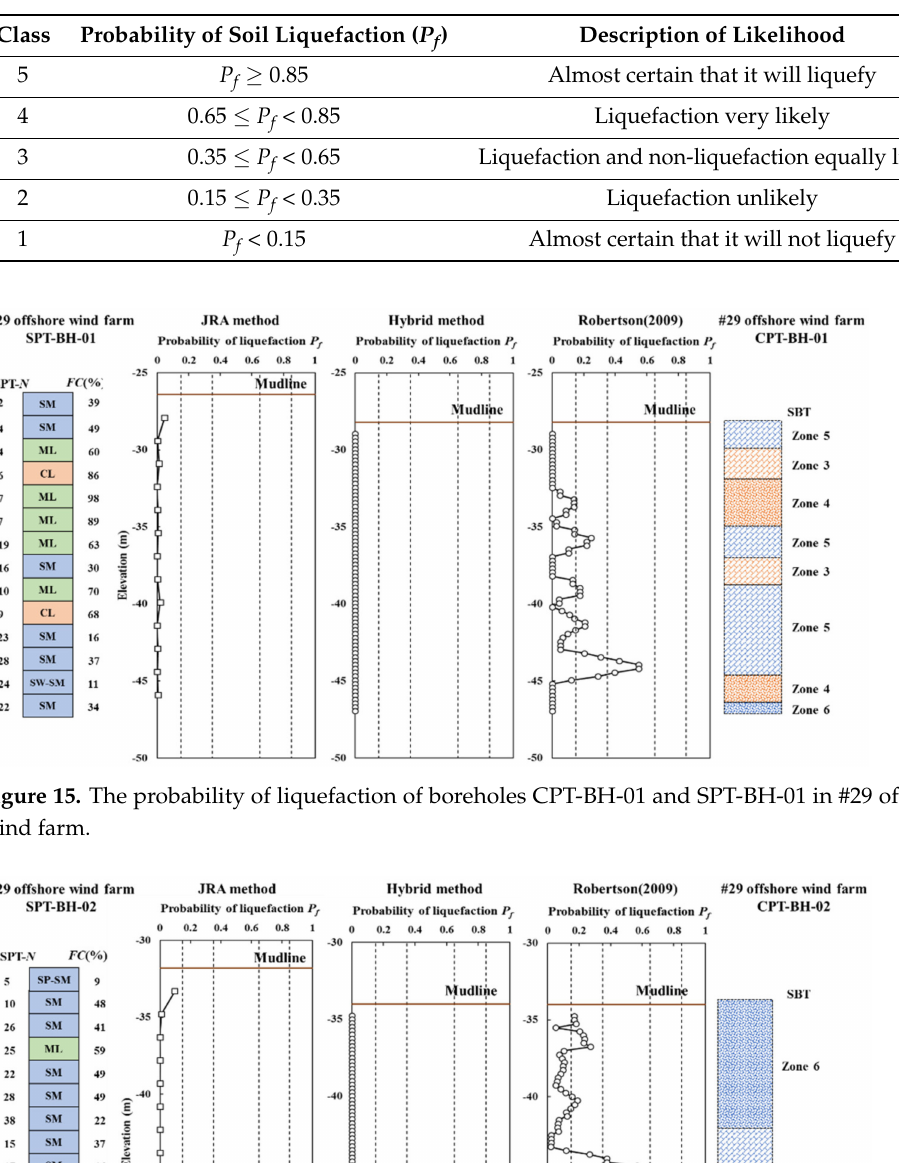
Table 3. Soil liquefaction likelihood classification.